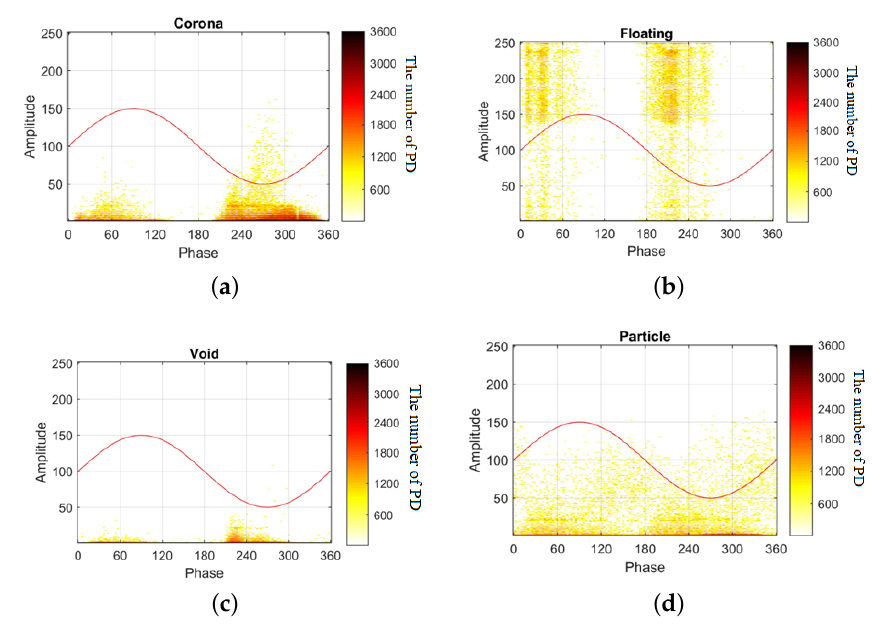
Figure 3. Two-dimensional representation of PRPDs in the gas-insulated switchgear (GIS): ( a ) corona, ( b ) floating, ( c ) void, and ( d ) particle